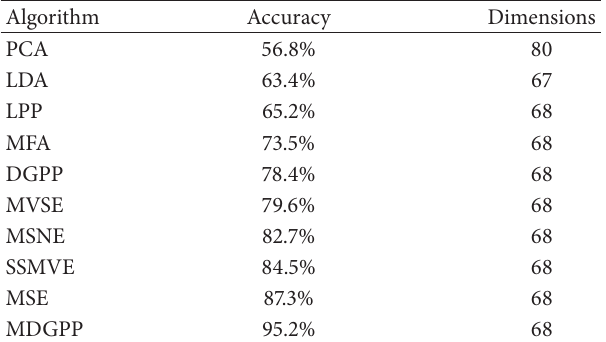
Table 2: Comparisons of recognition accuracy on the CMU PIE